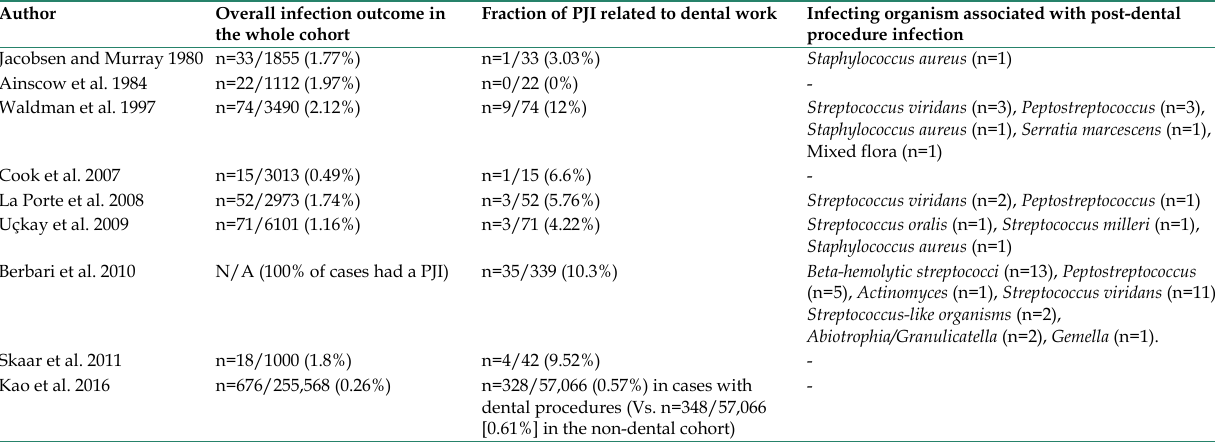
Table 4. Description of the included studies’ infection outcome.